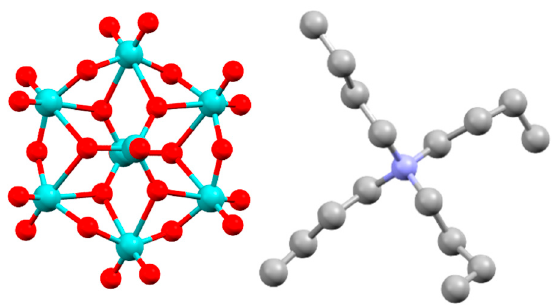
Figure 1. Mo 8 cluster with tetrabutylammonium cation [11].